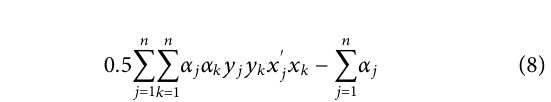
FIGURE 8 | VMD decomposition of Phase A (A) current (Branch 1) and (B) voltage (Busbar